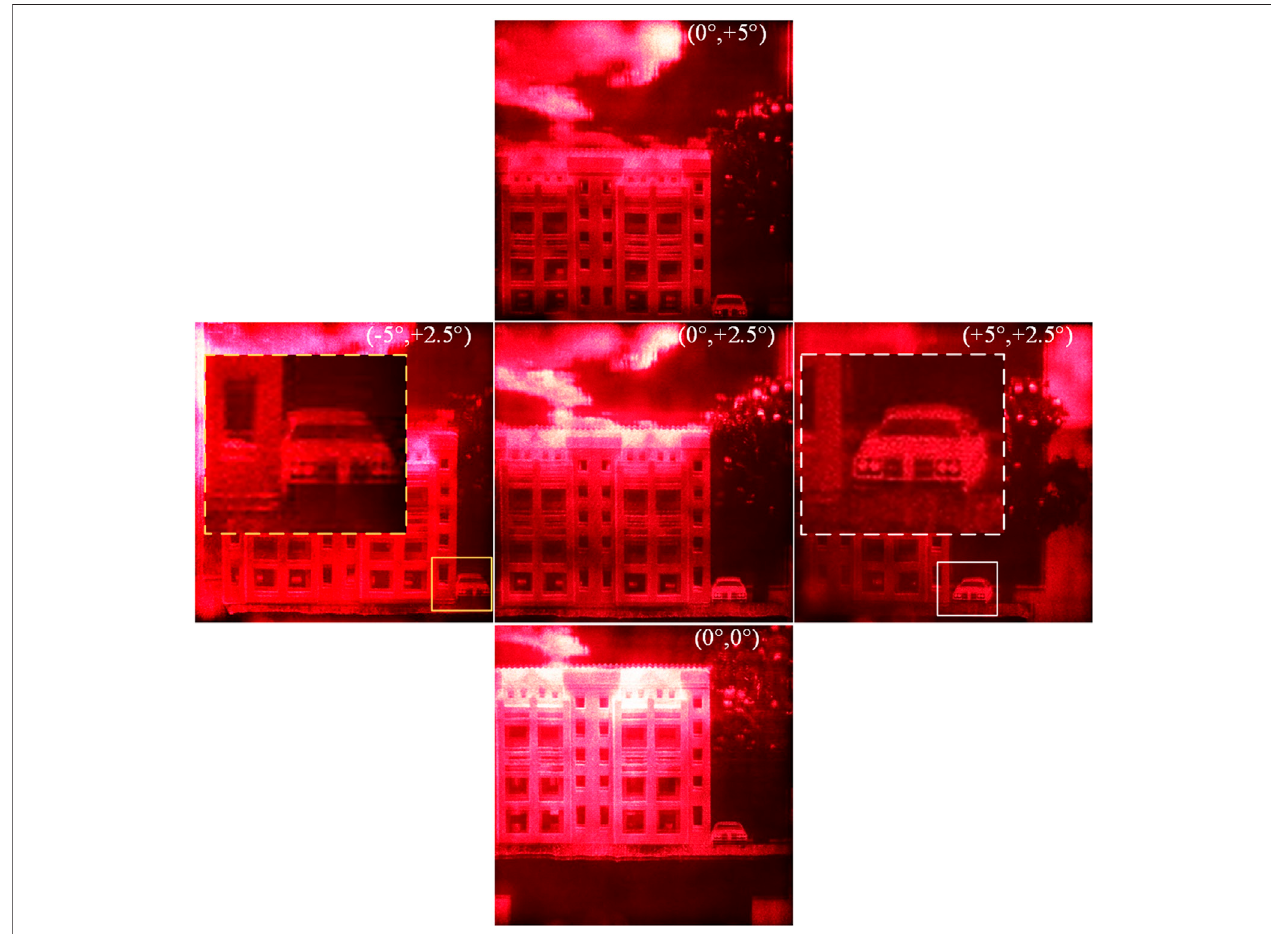
FIGURE 11 | Reproduction images of fi ve viewpoints.